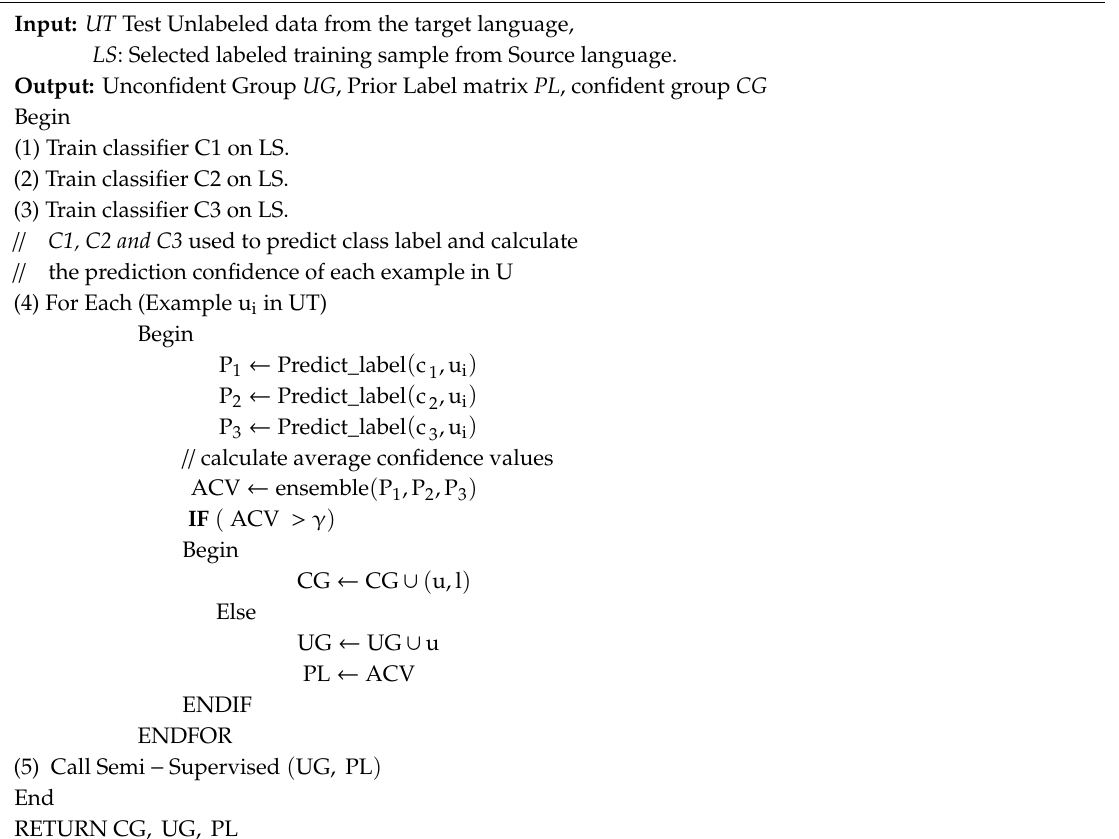
Algorithm 2. Algorithm for integrating prior supervised information with semi-supervised